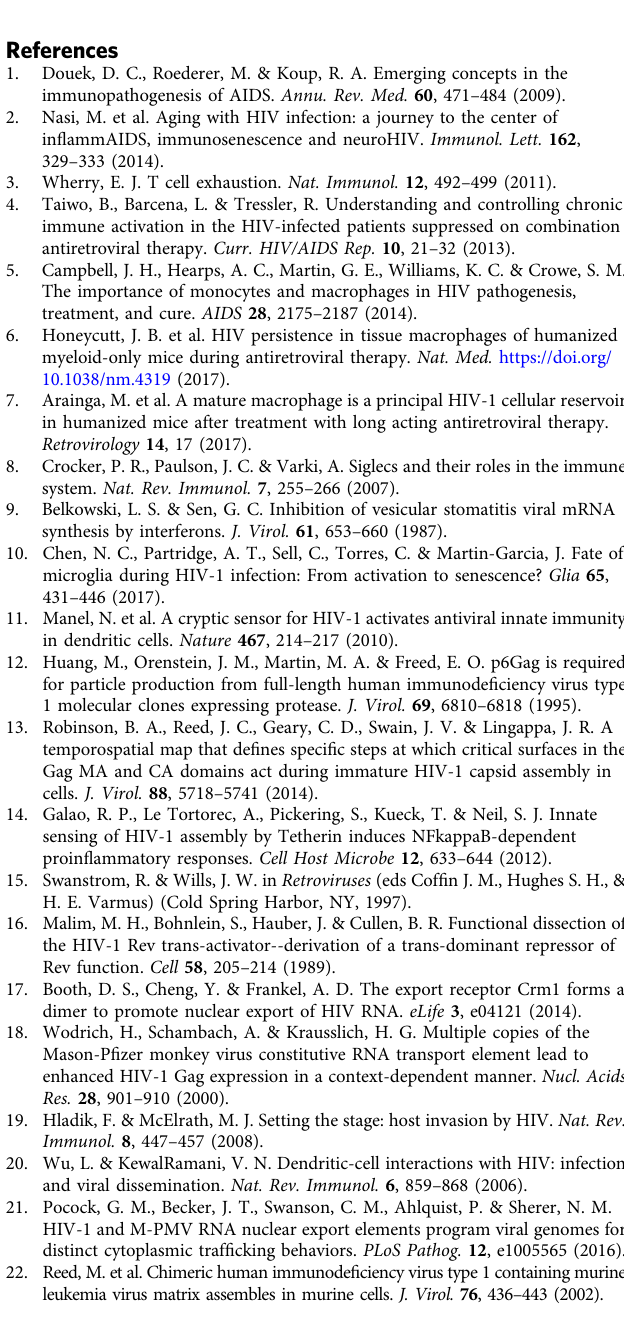
HIV-1 = 17, FIV = 6, HTLVII = 8, EIAV = 9; 4 m, n : HIV-1 = 15, FIV = 6, HTLVII = 8, EIAV = 9, mock = 20; 4n, n : HIV-1 = 9, FIV = 6, HTLVII = 8, EIAV = 9, mock = 13. Supplementary Fig. 5: 5a, n : Scrambled = 18, MAVS/ STING = 7, RIG-I = 5, MDA5 = 8; 5b, c, n = 7; 5d, n = 6; 5e, n = 8; 5f, n = 3; 5g, n : mock/DMSO = 13, (5Z)-7-Oxozeaenol/BAY11-7082 = 9, Herbimycin A = 7, Calpeptin = 6, Glybenclamide = 4; 5 h, n = 5; 5i, n : DMSO2/(5Z)-7-Oxozeaenol/ BAY11-7082 = 6, Herbimycin A/DMSO1 = 5, F = 0.3910, df = 27. Supplementary Fig. 6b – d, n =